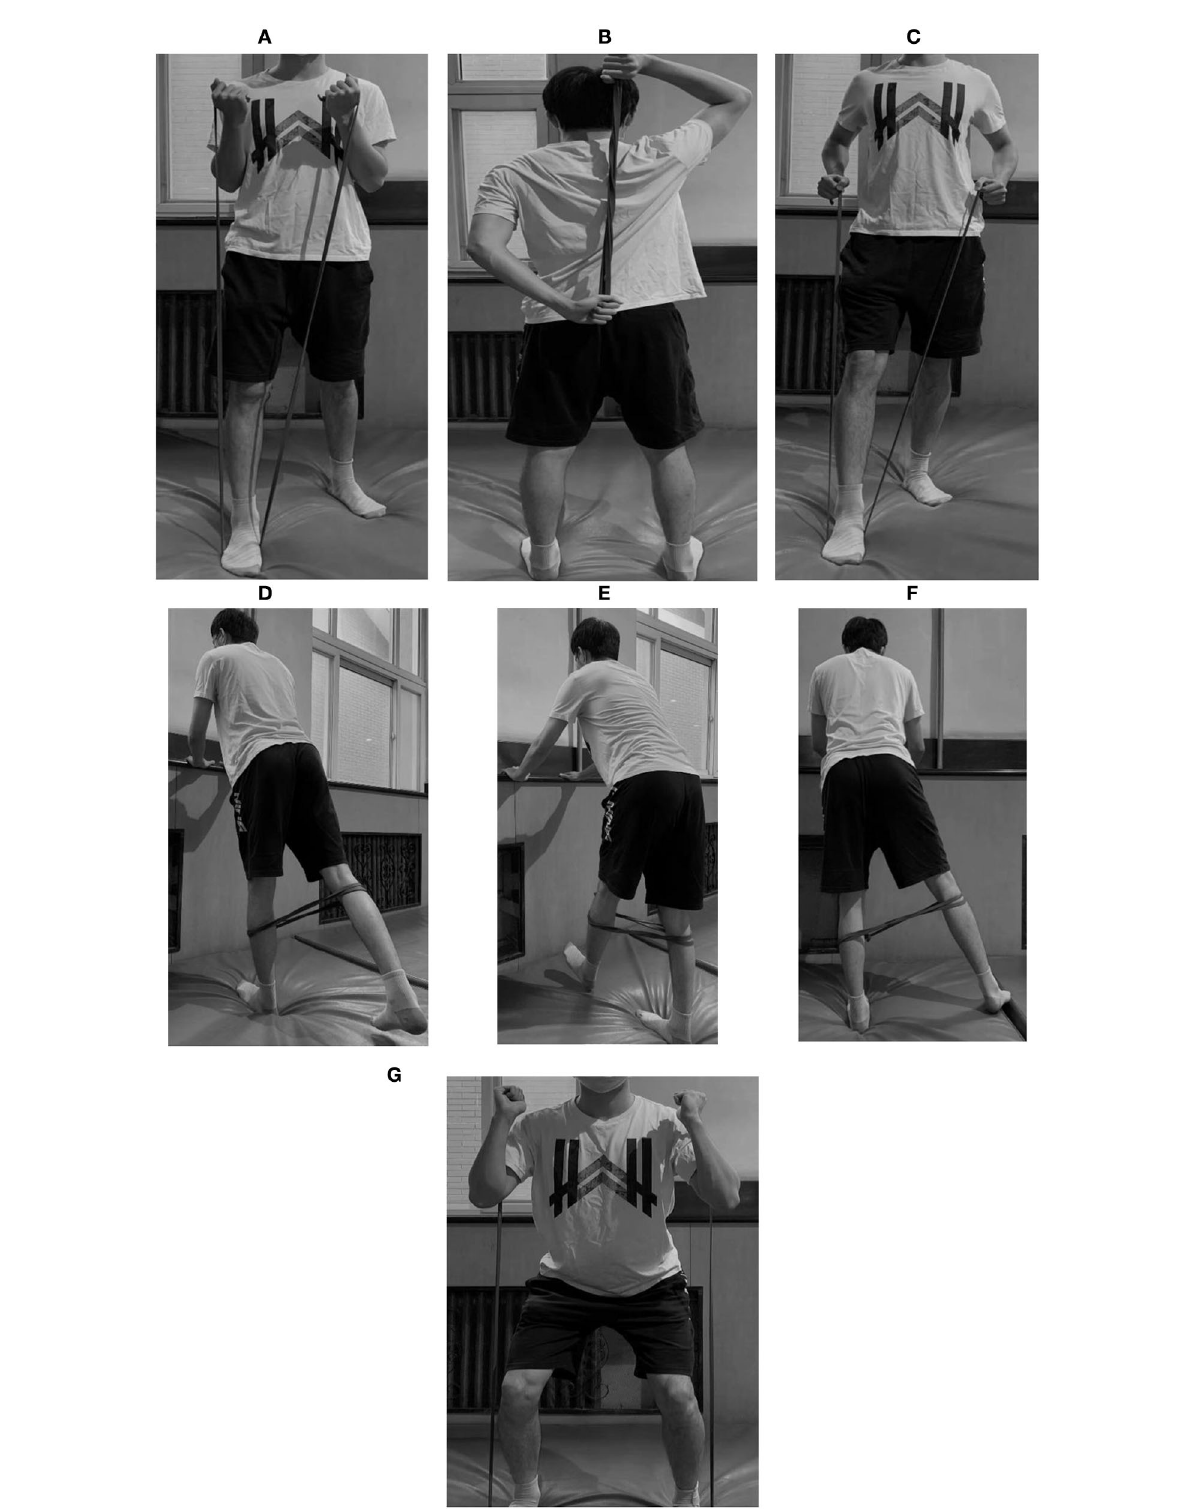
FIGURE1 Movements in elastic band training. (A) Standing elbow flexion. (B) Standing elbow extension. (C) Standing rowing. (D) Standing hip extension. (E) Standing hip flexion. (F) Standing hip abduction. (G)